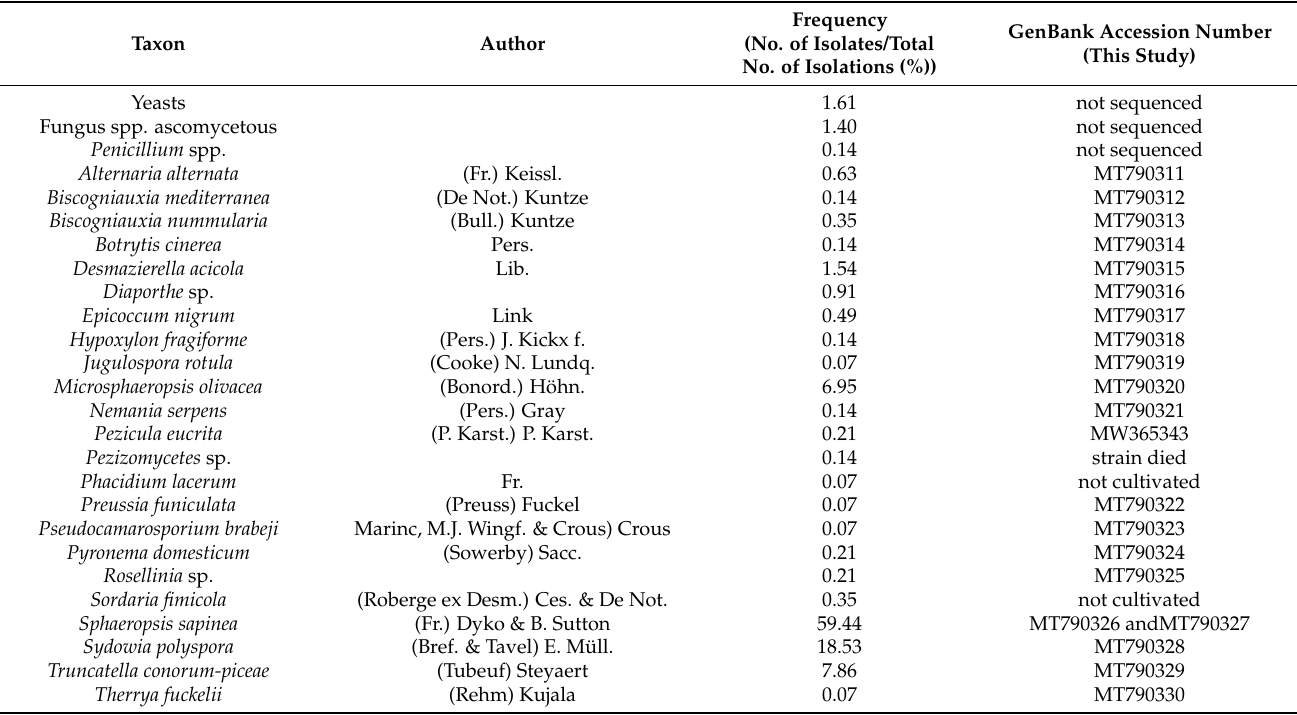
Table 2. Taxa isolated with the culture-based